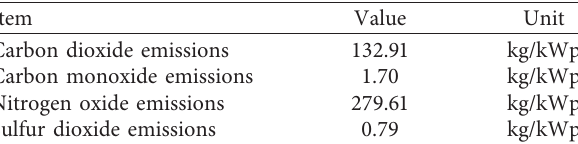
Table 1: Environmental impact inventory for multi-Si PV power production